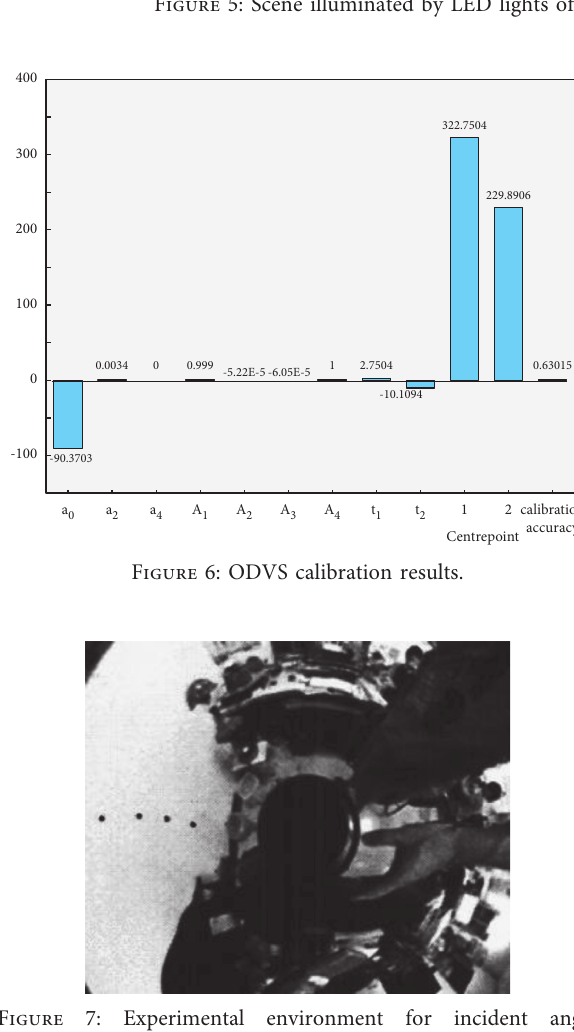
Figure 5: Scene illuminated by LED lights of different colors. (a) Red LED light; (b) blue LED light.